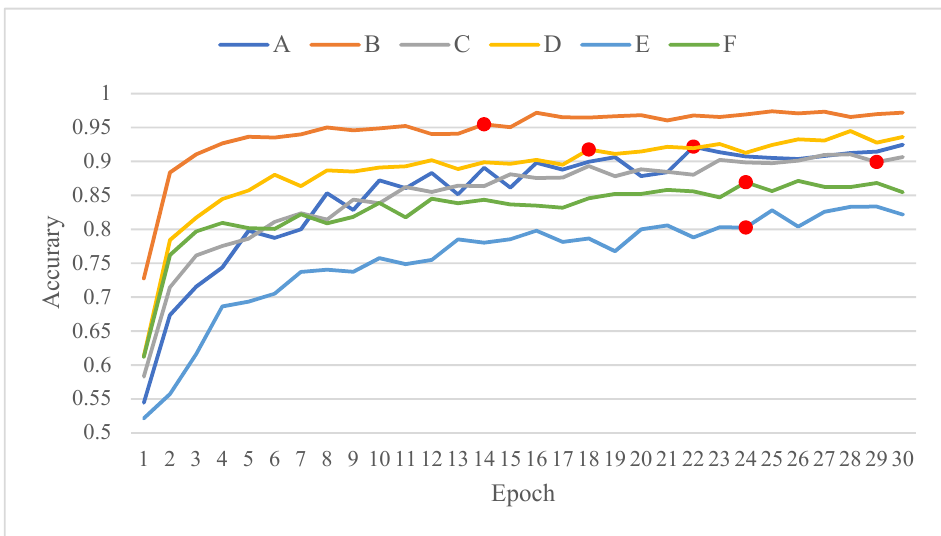
Figure 7. The accuracy of MCNN6 for six types of RC damage.